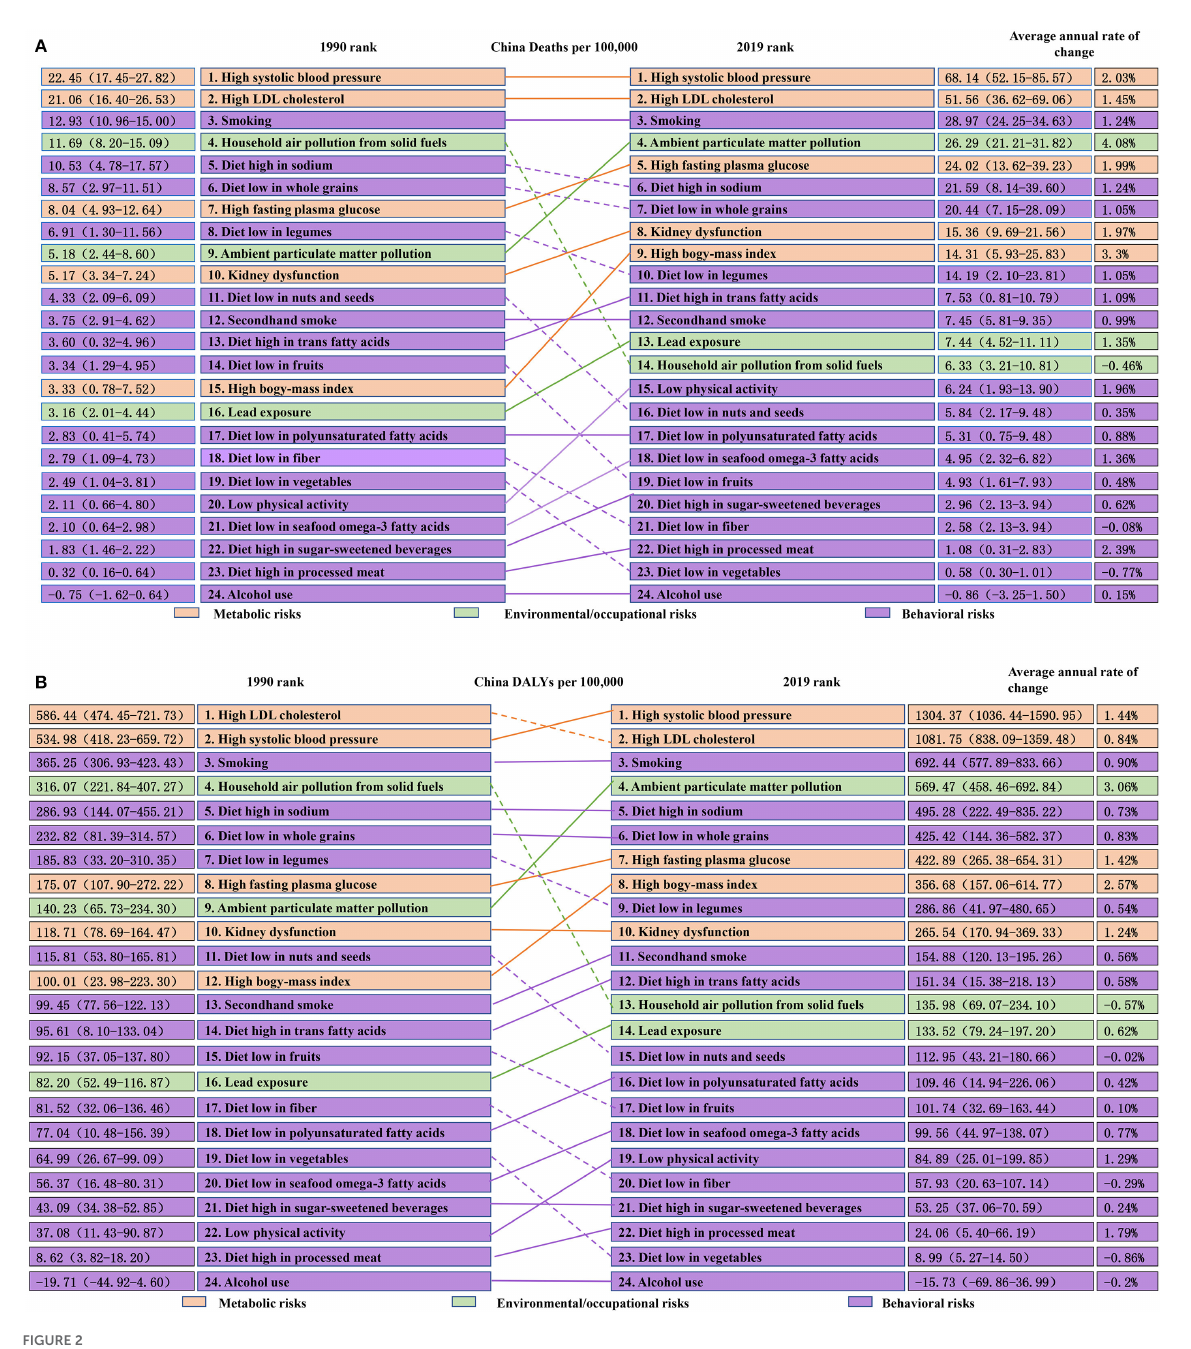
FIGURE2 (A) Death rate of risk factor-related IHD in China in 1990 and 2019 (1/100,000). (B) DALYs of risk factor-related IHD in China in 1990 and 2019